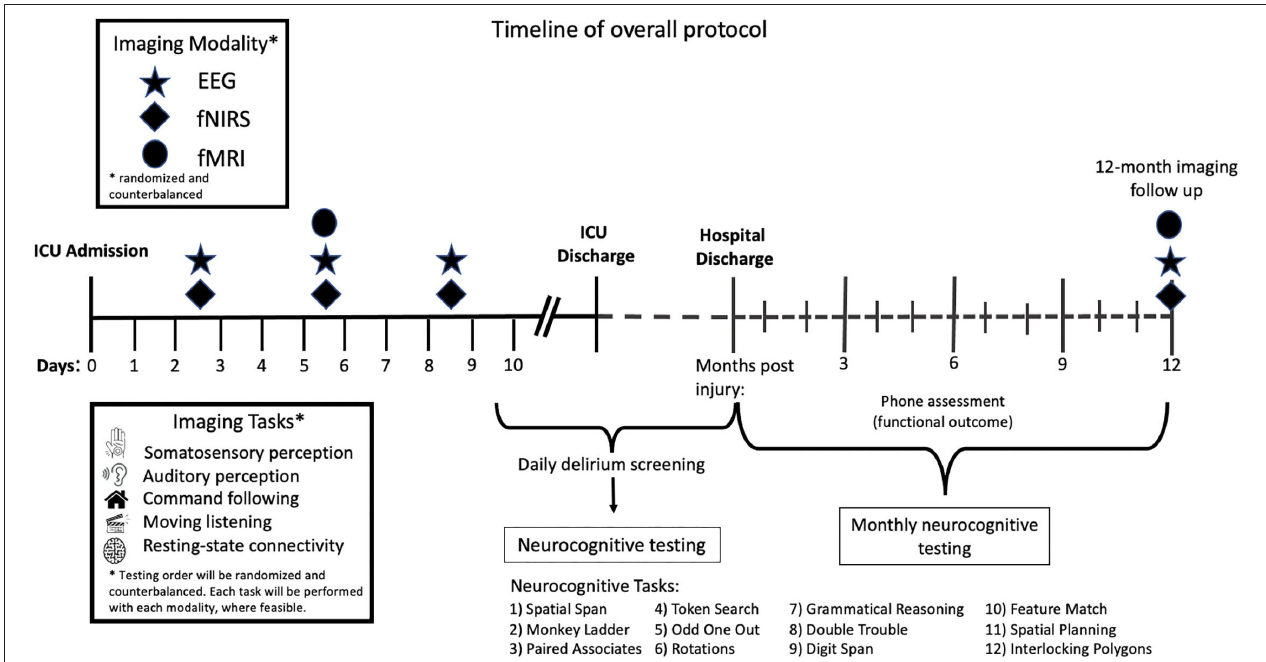
FIGURE 1 | Timeline of overall protocol. After 2–3 days in the ICU, patients will undergo both EEG and fNIRS testing. Between days 4–6 participants will undergo EEG, fNIRS, and fMRI testing. EEG and fNIRS testing will be repeated between days 7 and 10. The order of stimuli presented will be randomized and counterbalanced across all imaging modalities and time points. The order in which imaging modalities will be used at each time point across the timeline will also be counterbalanced and randomized. Patients will undergo neurocognitive testing using the Cambridge Brain Sciences (CBS) cognitive battery once in hospital when delirium has resolved, and then monthly for up to 12 months post injury. Phone assessments to assess functional outcome will take place 3-, 6-, and 12-months post